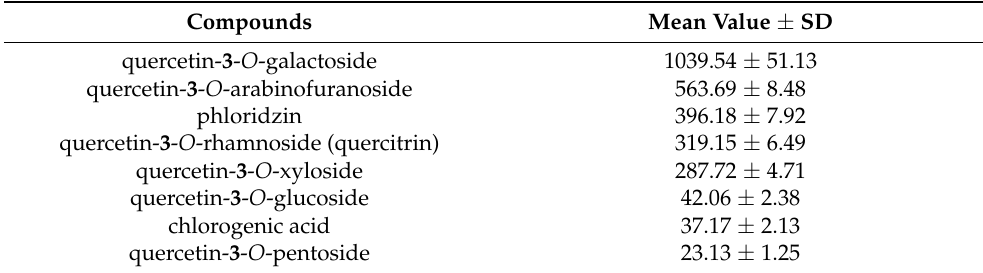
Table 2. Phenolic content (mg/kg) in AP (mean values ± SD, n =